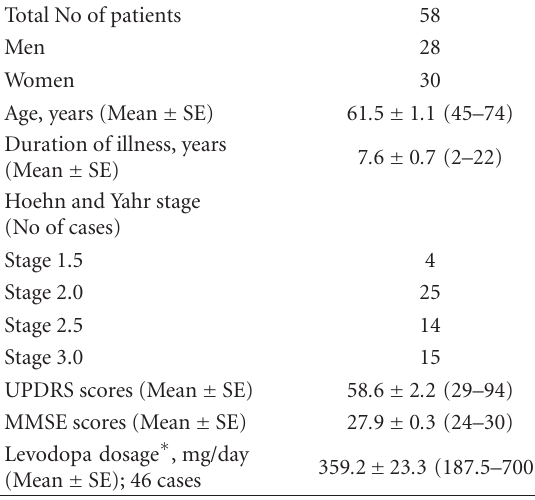
Table 1: Backgrounds of patients with Parkinson’s